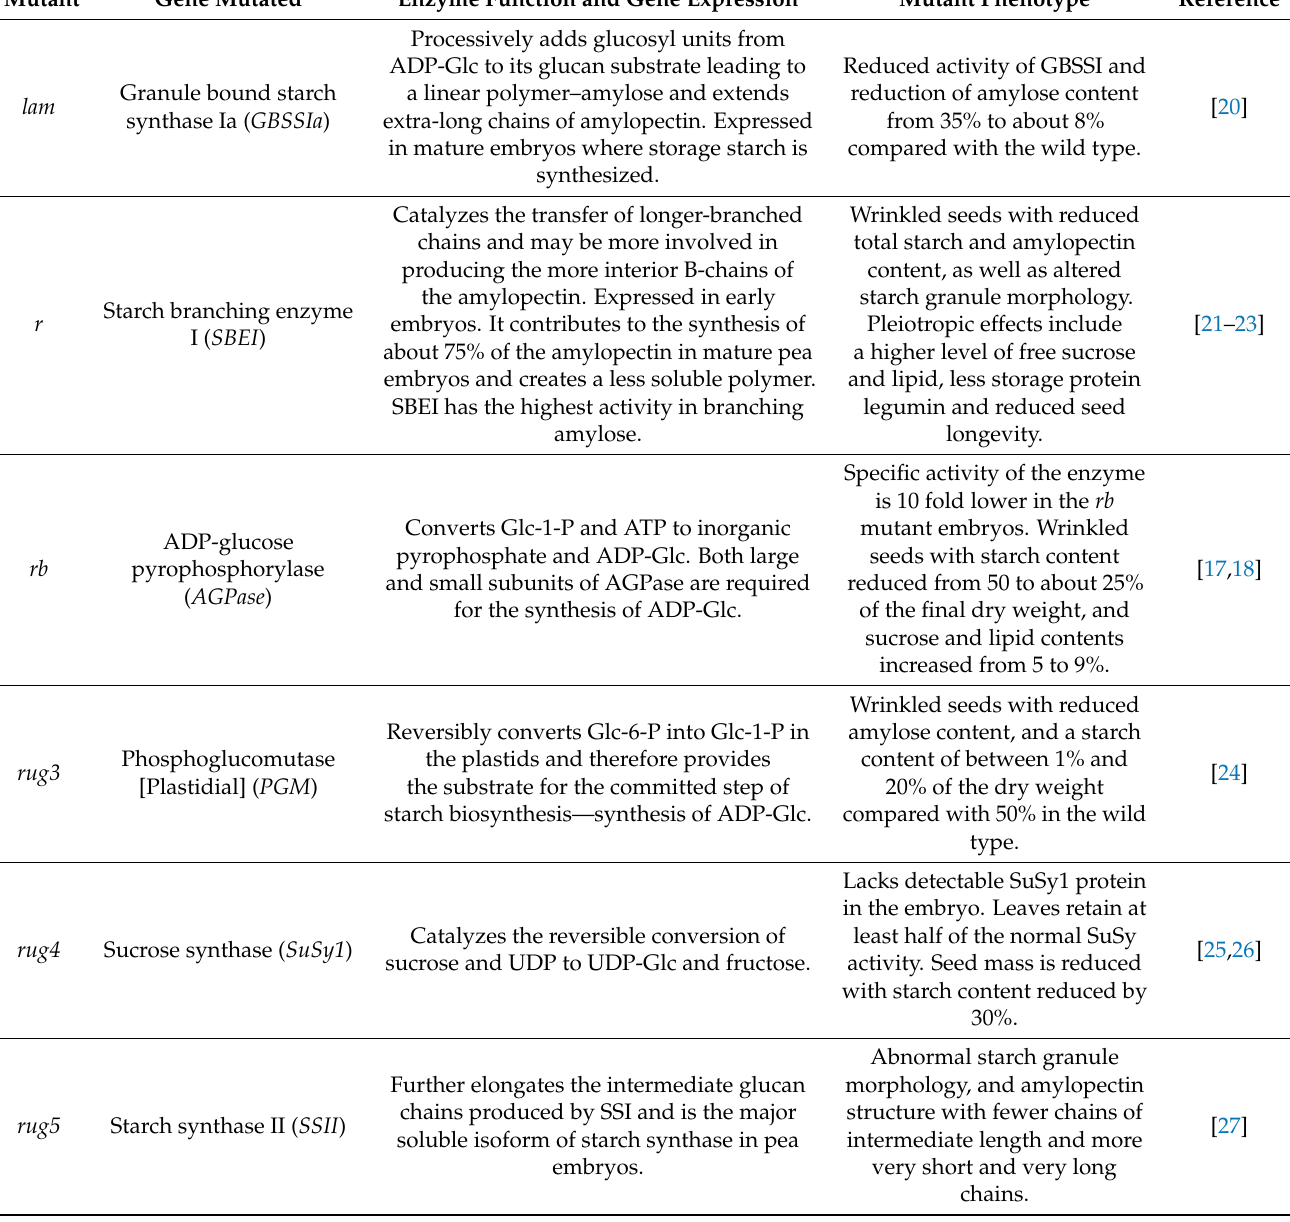
Table 1. Overview of Pea Mutants with Defects in Starch